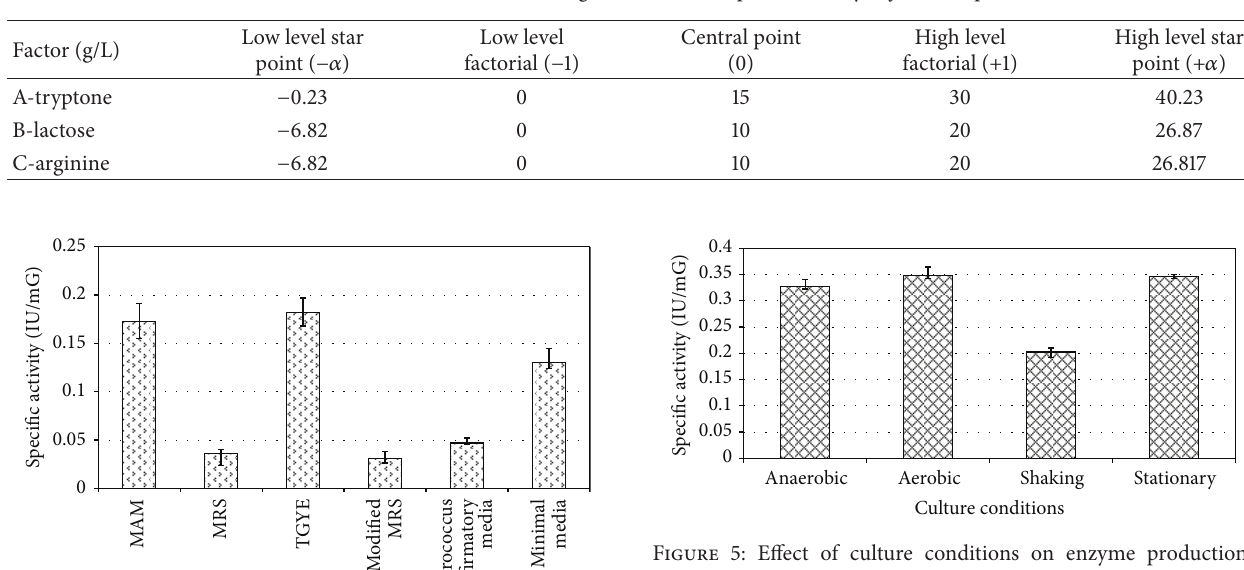
Table 1: Variables and their levels for arginine deiminase production by E. faecium sp. GR7.